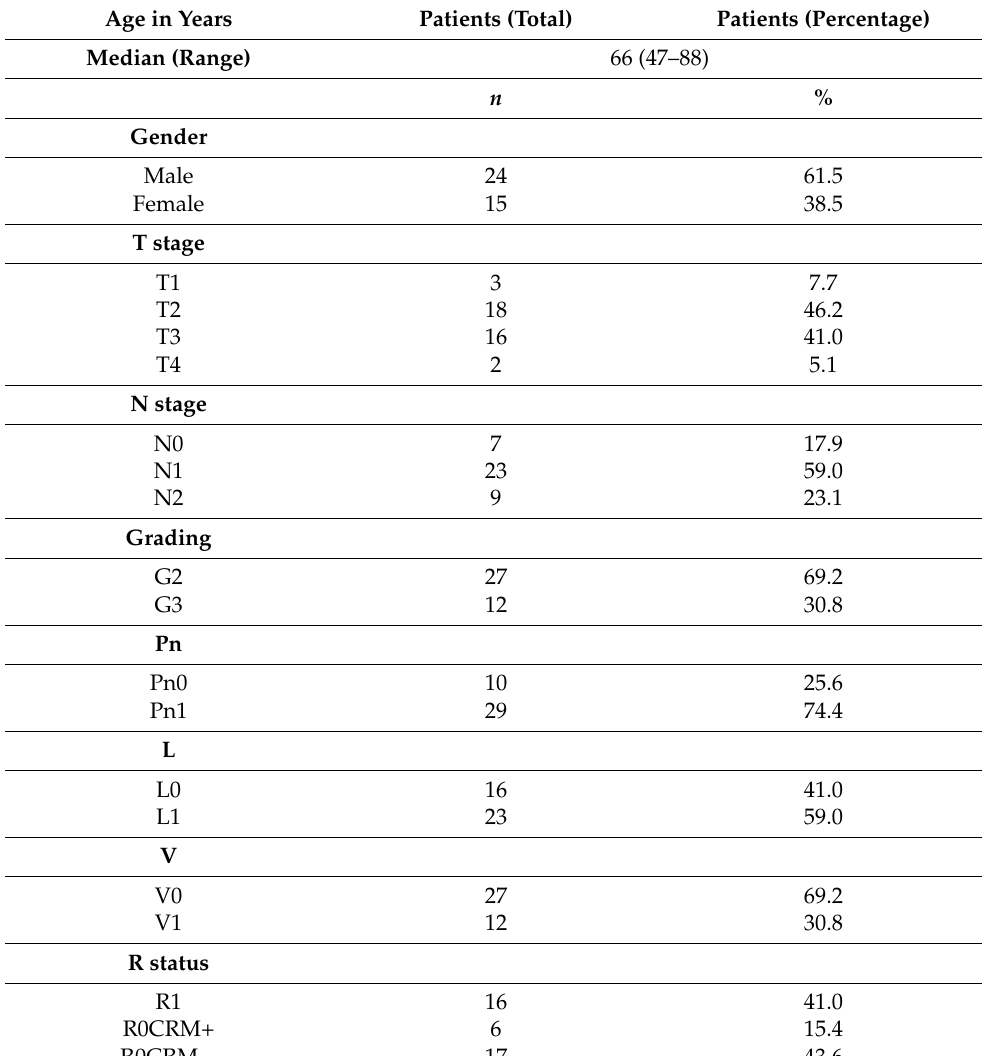
Table 1. Demographic data of the patient cohort from 2004–2016; n = 39. Most patients were diagnosed with an advanced stage of